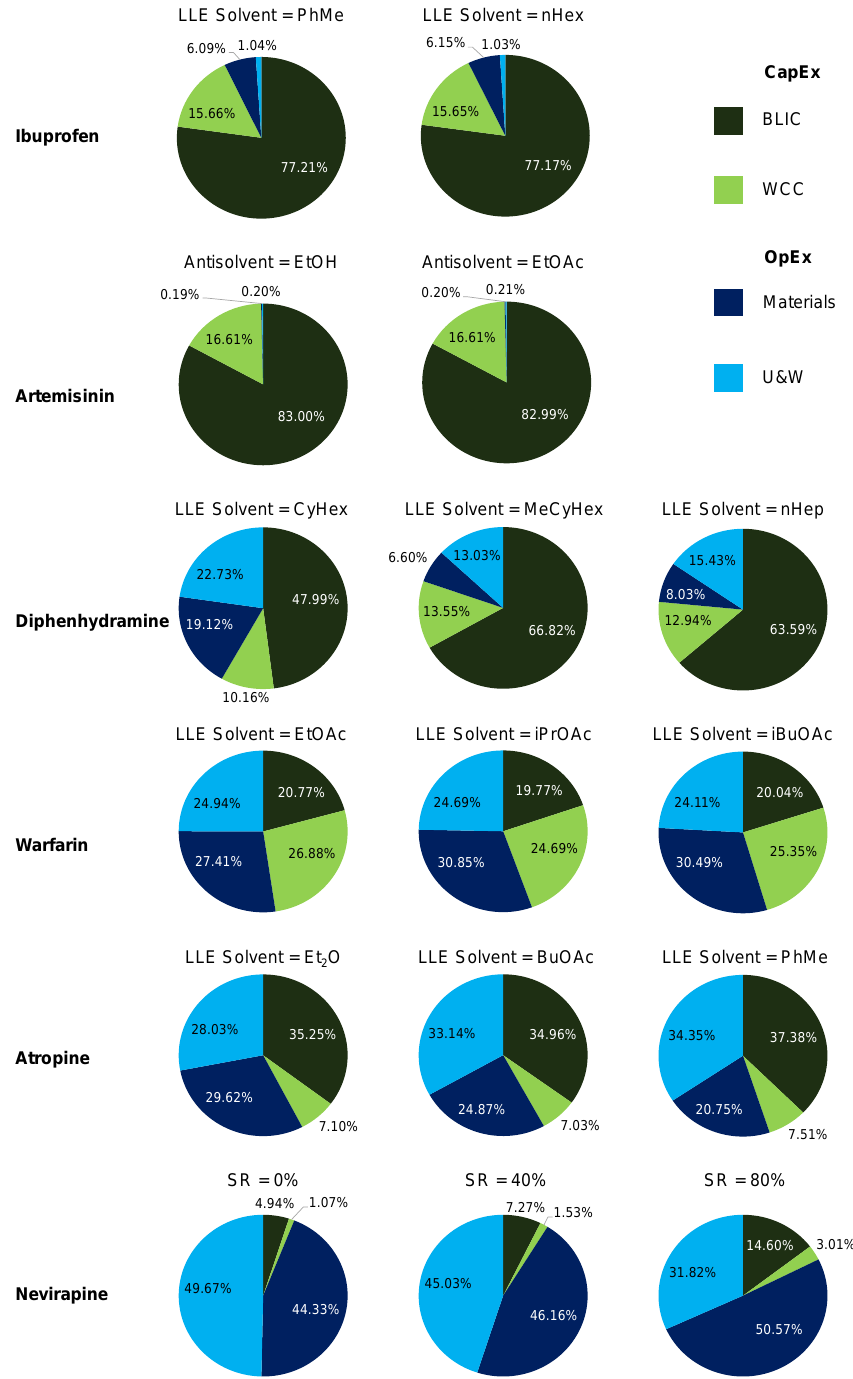
Figure 20. Total cost contributions towards API production.